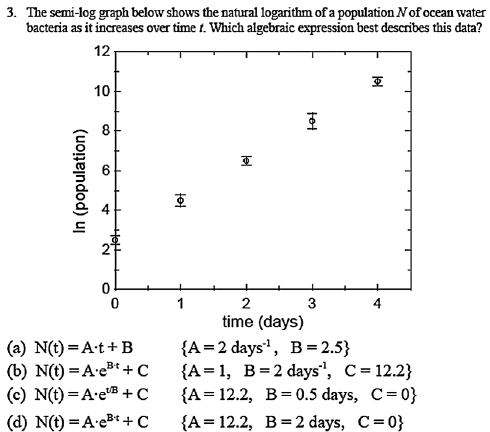
FIG. 3. Item 3 assesses a student’s ability to interpret data displayed as a straight line on a semilog plot. The answer is most efficiently reached through applying knowledge that straight lines on semilog plots reflect exponential behavior, along with a basic knowledge of logarithm algebra and dimensional analysis. The distractors include (a) a straight line, ignoring the logarithm entirely, (b) the common problem of students attempting to work this out algebraically but failing to correctly manage the intercept in the calculation, and (d) the correct functional form but with incorrect units of the coefficient in the exponential. This question contains a hint to the correct answer in the form of physics content rather than pure knowledge of functions and graphs; that is, students might be helped by remembering that population growth is very often described by an exponential FIG. 4. Item 4 assesses a student’s ability to interpret data displayed as a straight line on a log-log plot. The answer is most efficiently reached through applying knowledge that straight lines on log-log plots reflect power-law behavior (with the power given by the slope), along with a basic knowledge of logarithm algebra and dimensional analysis. The distractors include (a) the common problem of treating the intercept on the graph incorrectly in their algebraic conversion of the logarithm, (b) in which the logarithms are ignored entirely and the formula for a straight line is given, and (d) the correct functional form but with incorrect units for the coefficients. This question contains a hint to the correct answer in the form of physics content rather than pure knowledge of func- tions and graphs; that is, students might be helped if they are cognizant of the Stefan-Boltzmann